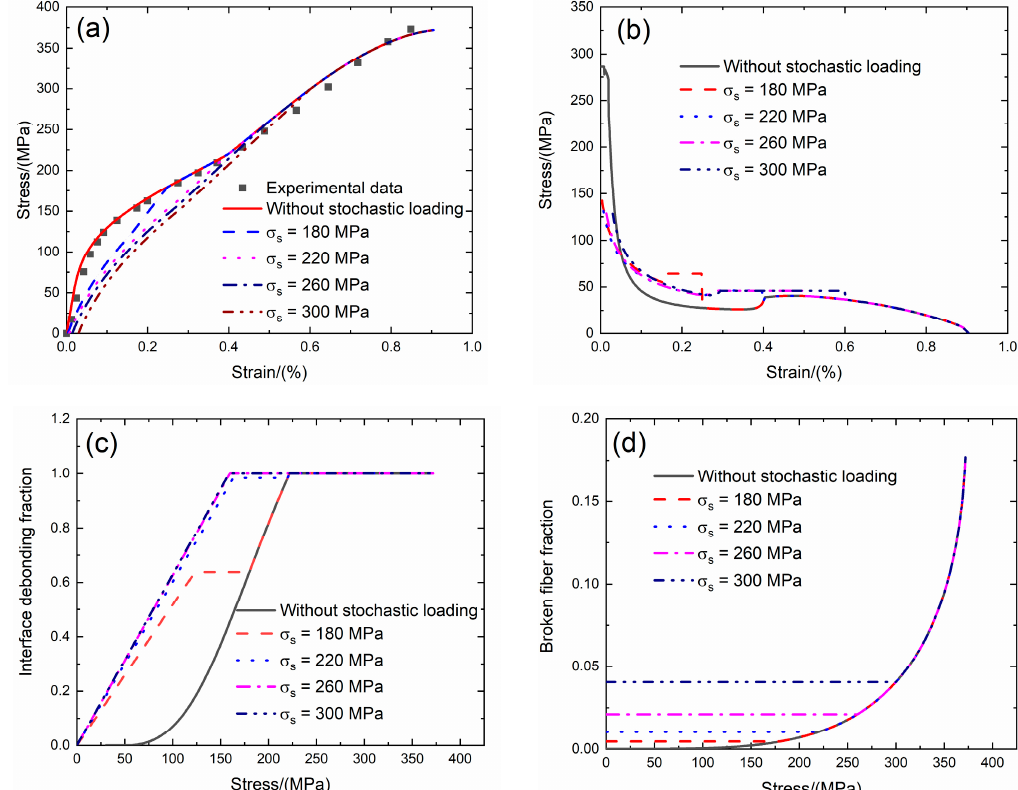
Figure 17. ( a ) The tensile stress–strain curves; ( b ) the tangent modulus versus strain curves; ( c ) the interface debonding fraction versus stress curves; and ( d ) the broken fibers fraction versus stress curves of 2D SiC/SiC composite for conditions without stochastic loading and with stochastic loading of σ s = 180, 220, 260 and 300 MPa. Table 10. The tensile stress–strain curve, tangent modulus, interface debonding fraction and broken fiber fraction of 2D SiC/SiC composite subjected to stochastic loading of σ s = 180, 220, 260 and 300 MPa.